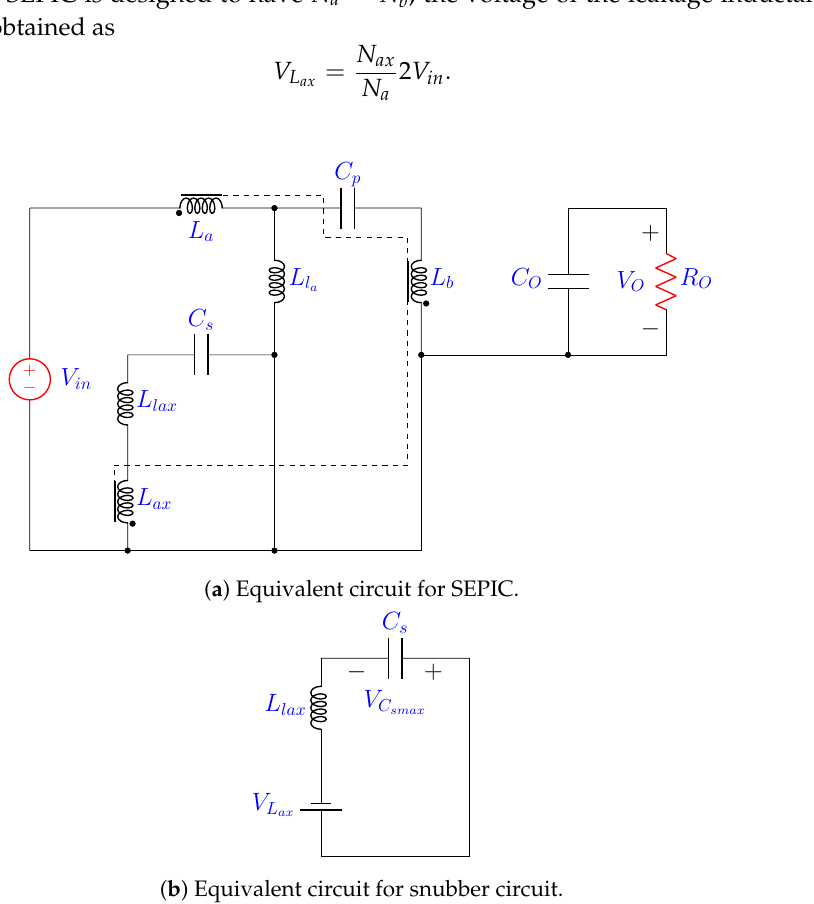
Figure 5. Equivalent circuit at the first state in the turn ON period for SEPIC and snubber